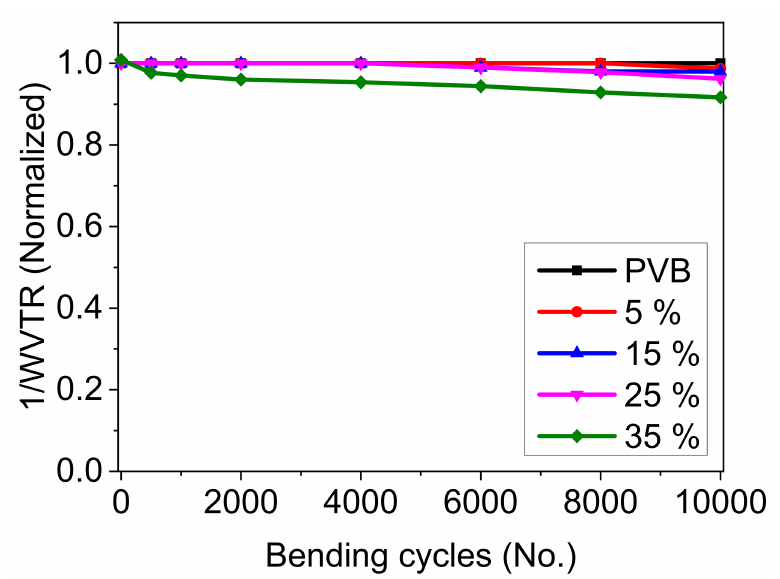
Figure 6. Permeation in terms of normalized 1/WVTR of the PVB layer containing flakes from 5–25 vol% after 10,000 bending cycles at a radius of 3 cm.